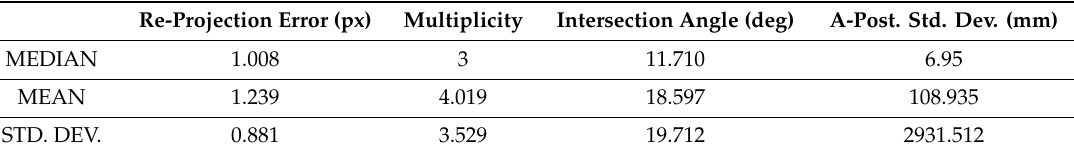
Table 8. Median, mean and standard deviation values for quality feature values computed on the original (not filtered) sparse point cloud (~640,000 3D tie points).